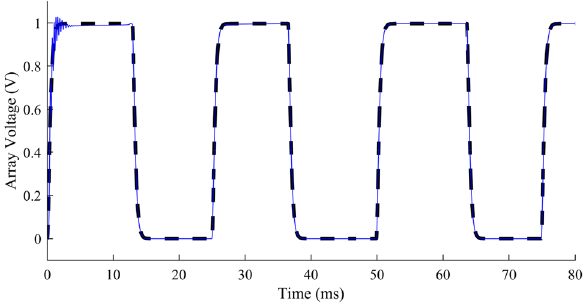
Figure 18. Output performance of the proposed HFLAG-MRAC under varying solar